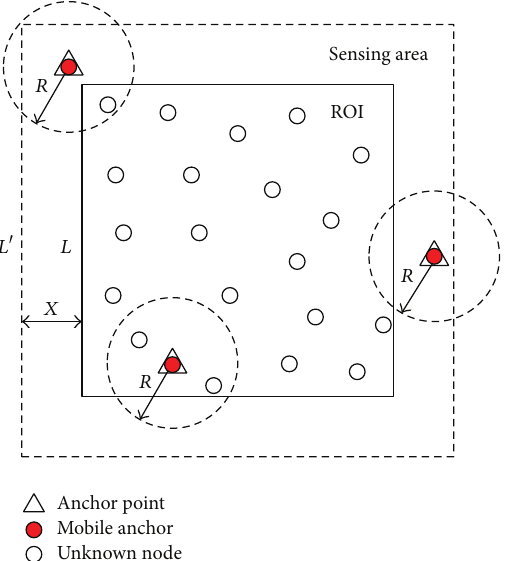
Figure 7: Movement trajectory of MAALRH with a boundary com- pensation